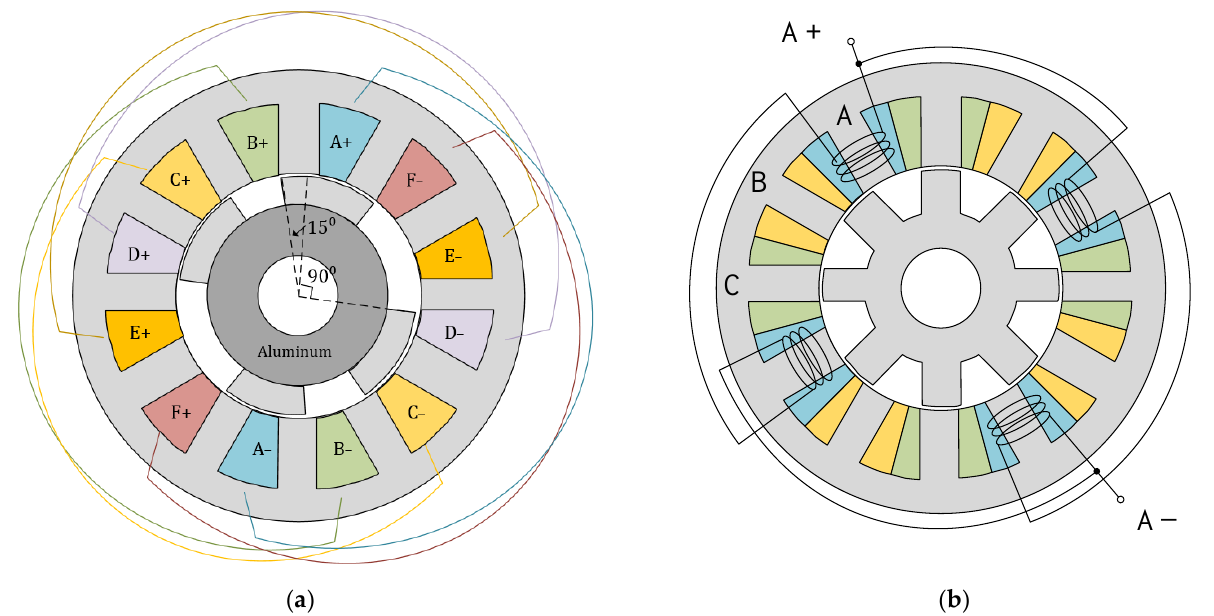
Figure 1. The structure of the SRMs: ( a ) the proposed segmental SRM; ( b ) a conventional SRM.